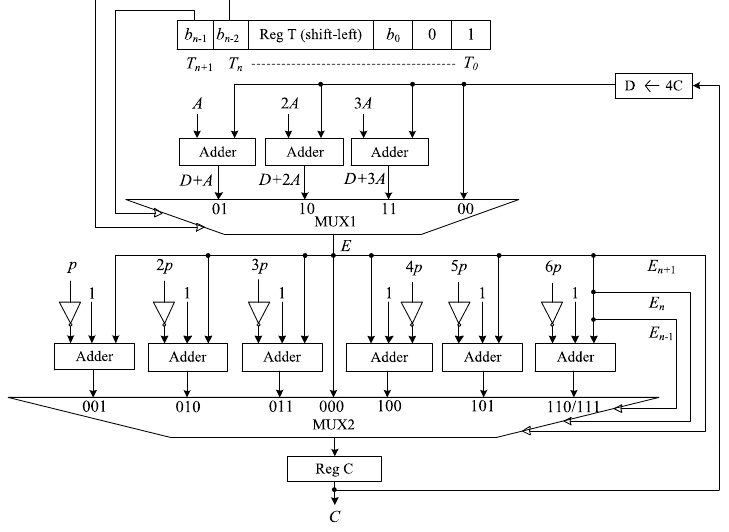
Figure 2. Proposed modular multiplier.